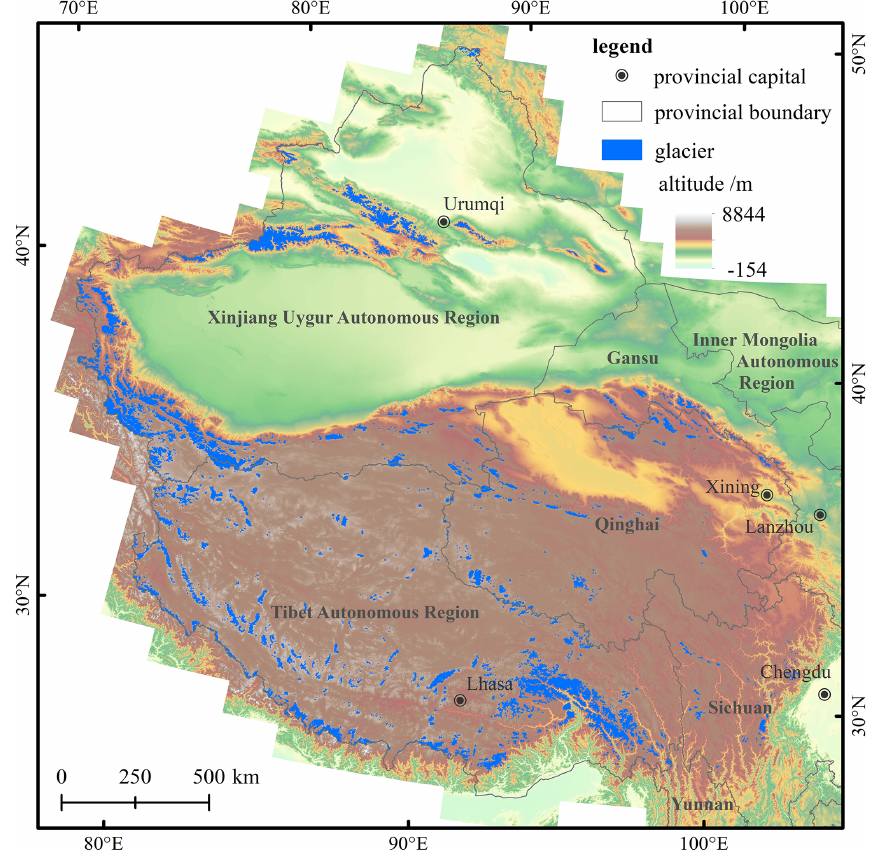
Figure 1. The distribution of glaciers in China.